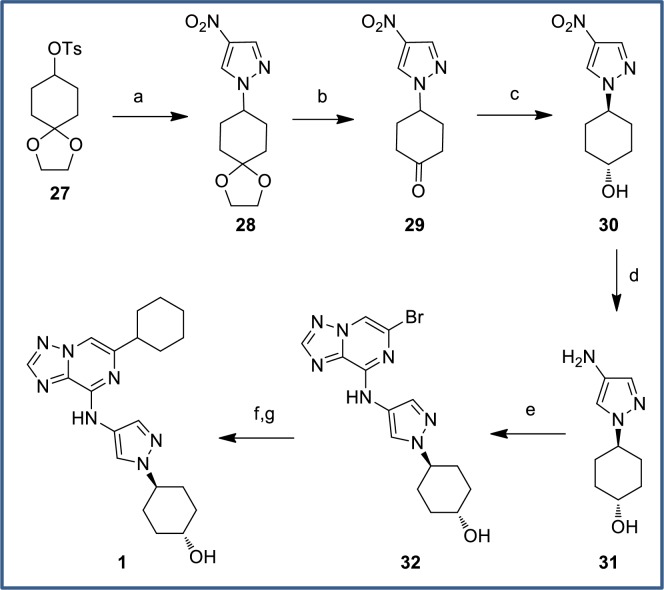
Synthesis of secondary alcohol 1.Reagents and conditions: (a) 4-nitropyrazole, Cs2CO3, DMF, 77% (b) PPTS, acetone/H2O, 88%; (c) NaBH4, EtOH, -5°C; recrystallization from toluene, 59%; (d) Pd/C, H2 (1 atm), MeOH, rt, 98%; (e) 24, DIPEA, DMF, rt, 97%; (f) cyclohex-1-en-1-ylboronic acid, Pd(PPh3)2Cl2, Cs2CO3, 1,4-dioxane/water, 90°C, quant; (g) Pd(OH)2, H2 (1 atm), THF/MeOH/AcOH, rt, 85%.